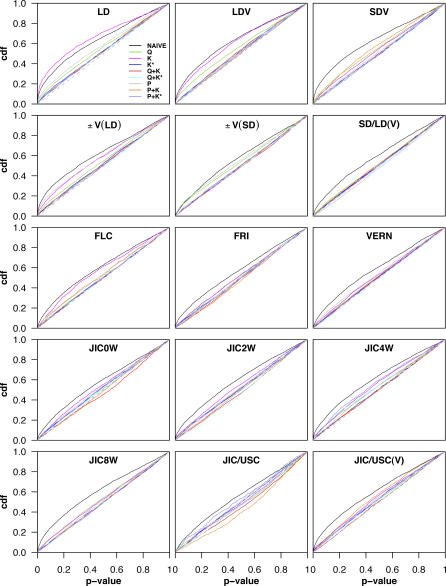
The Cumulative Distribution of p-Values in Genome-Wide Scans for All PhenotypesThe different curves correspond to different approaches for correcting for population structure (described in Table 2). Without correction for population structure, all distributions are strongly skewed towards significance. The results shown here are for associations between phenotype and individual SNPs: results for haplotypes were very similar (see Figure S2).cdf, cumulative distribution function